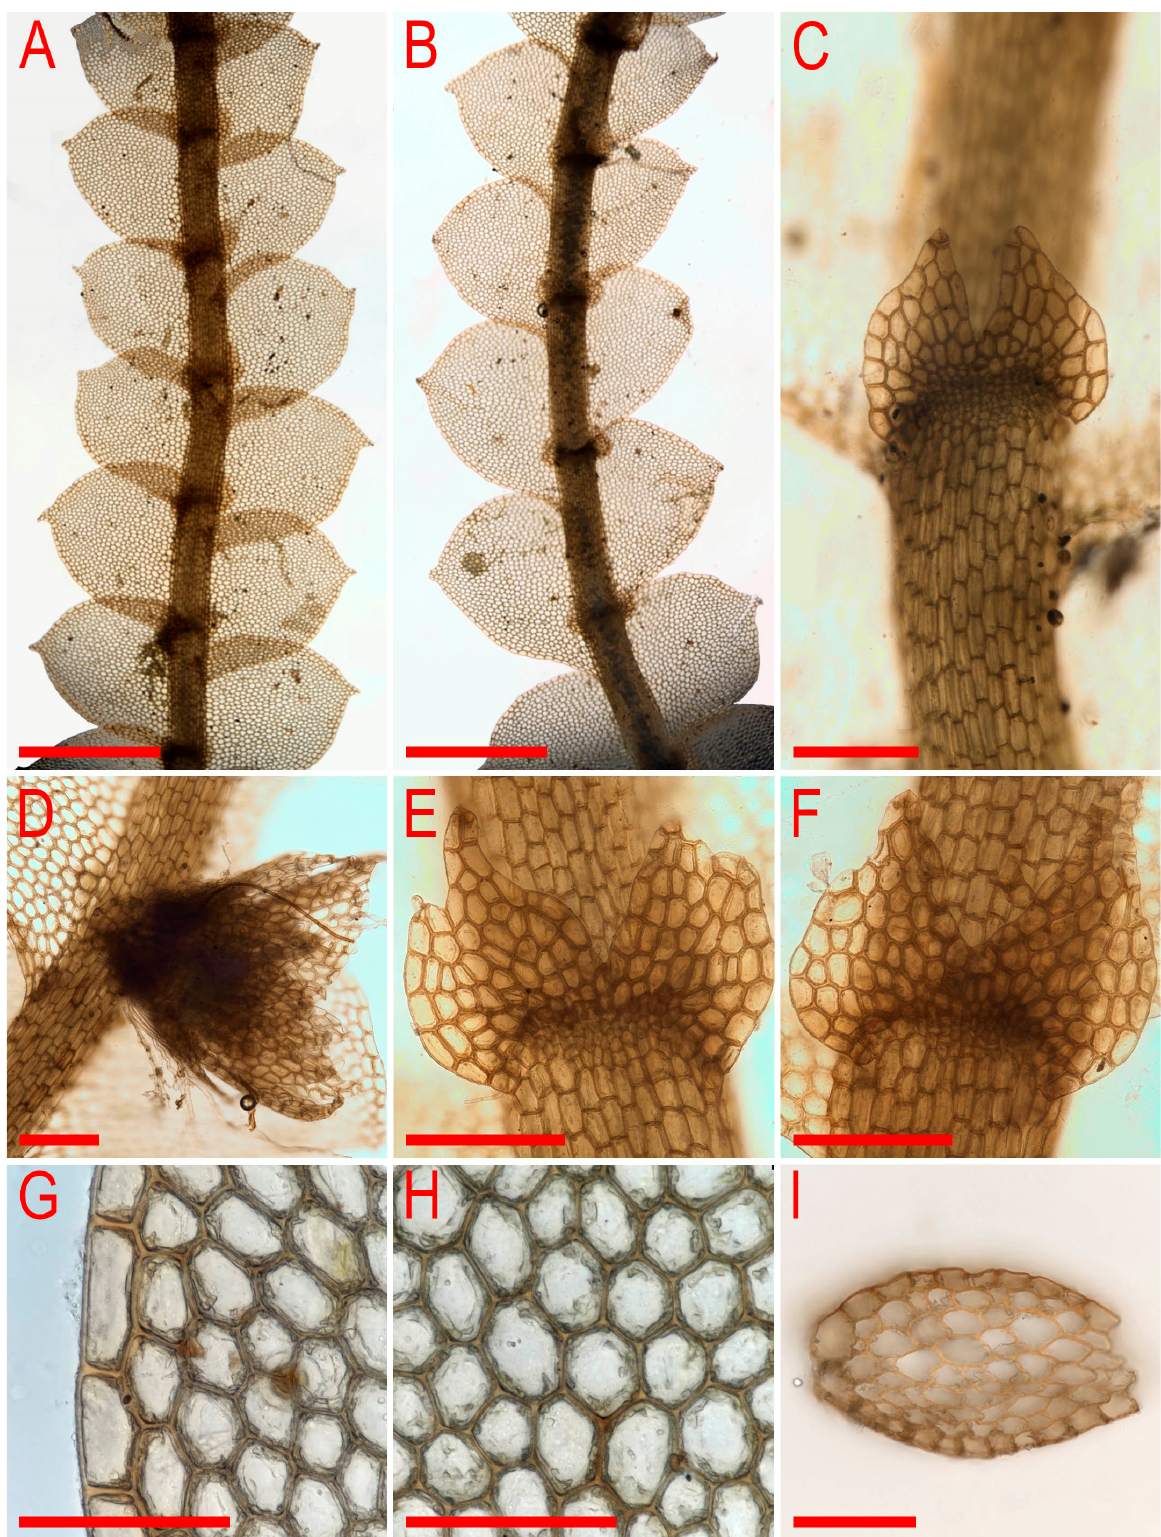
Figure 15. Calypogeia pseudocuspidata Bakalin, Frank Müll. et Troizk., sp. nov. : ( A ) Plant habit, fragment, dorsal view; ( B ) Plant habit, fragment, ventral view; ( C,E,F ) Underleaves; ( D ) Archegonia; ( G ) Leaf margin cells; ( H ) Midleaf cells; ( J ) Stem cross section. Scales: 1 mm for ( A , B ); 200 μ m for ( C – F ); 100 μ m for ( G – I ). All from 13-081-094-G (DR, VBGI).